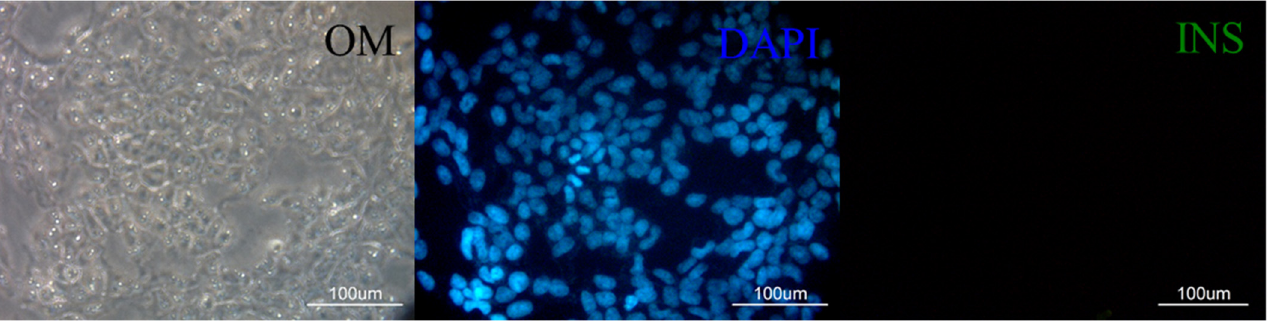
Figure 3. IHC images of optical, DAPI-staining, and anti-insulin staining in HEK-293T cells without RNPs/MPIPs.